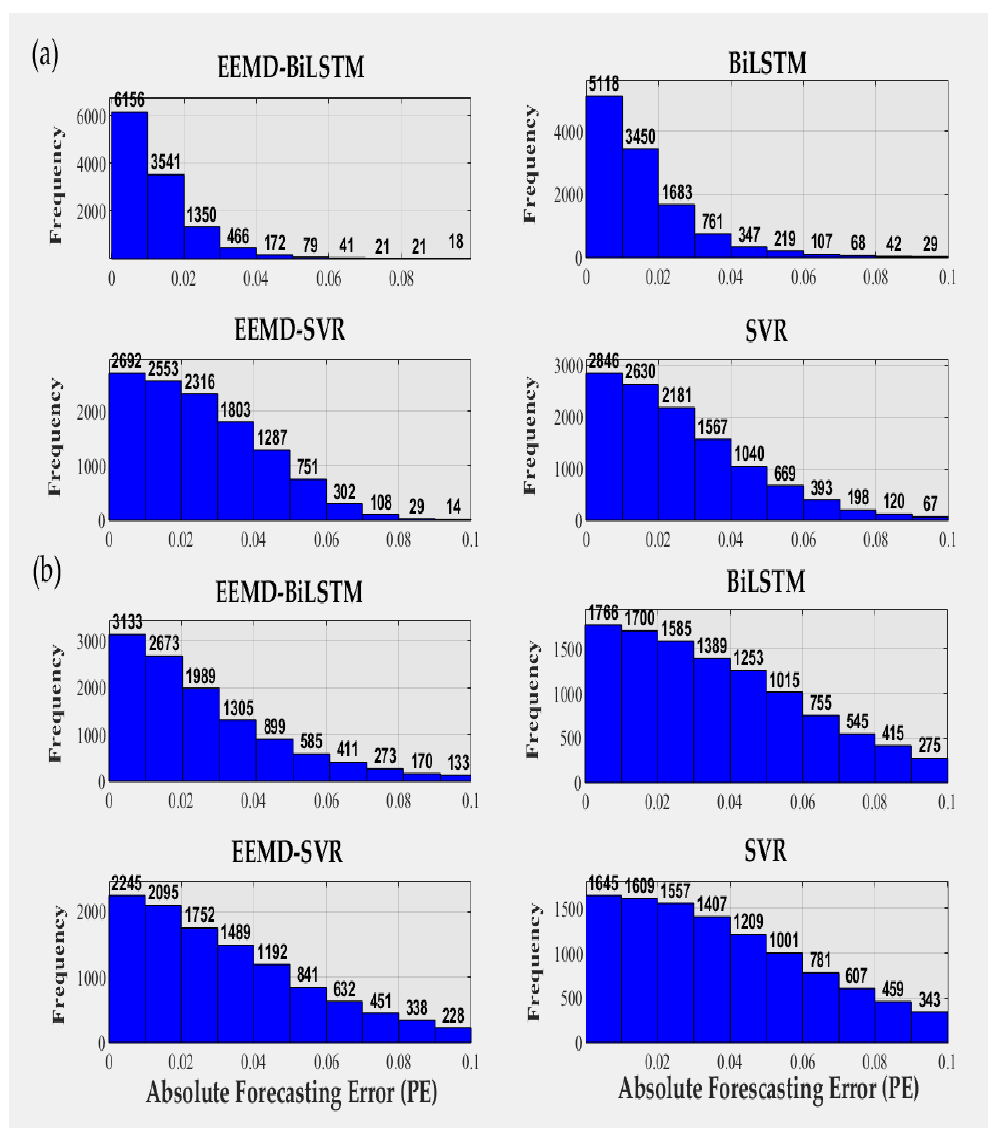
Figure 14. Histograms of absolute forecasting error (PE) generated by EEMD-BiLSTM and the benchmark models for ( a ) Cairns and ( b ) Gold Coast data sites.